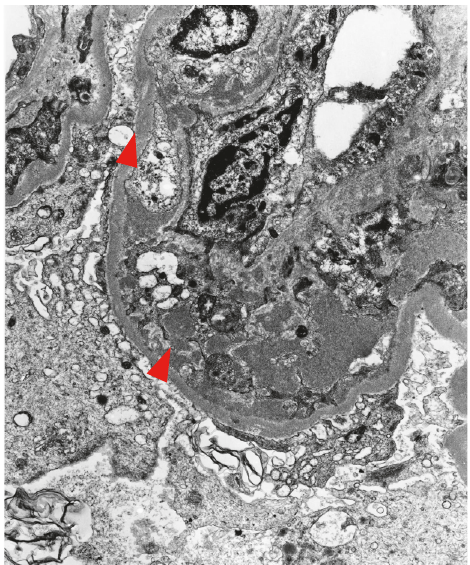
Figure 3: Electron microscopy: subendothelial and subepithelial electron dense deposits of cryoglobulins